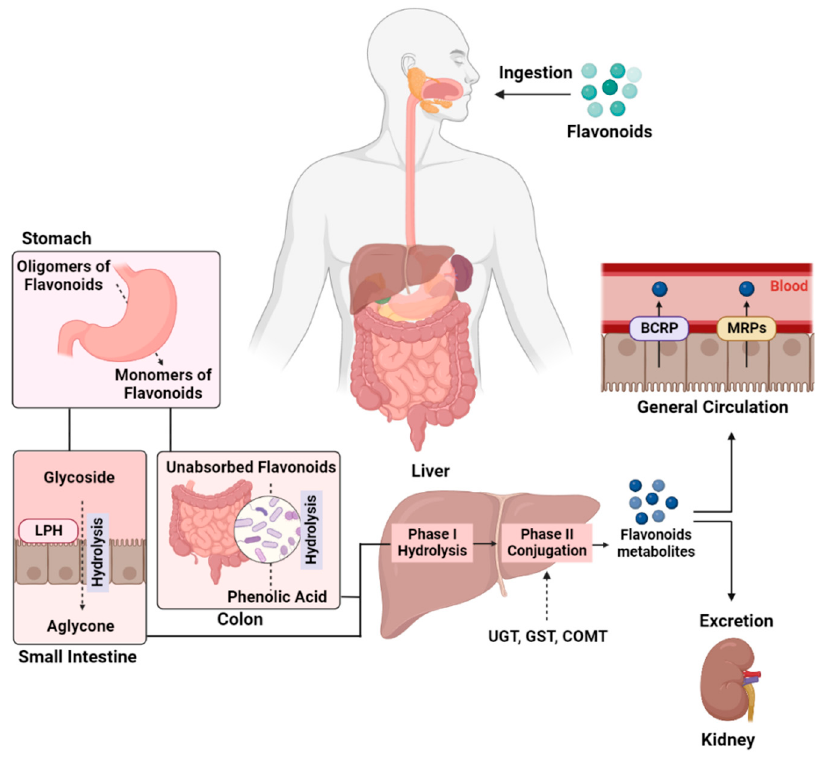
Figure 1. Bioavailability and metabolism of flavonoids. After ingestion, flavonoids hydrolyze into monomers in the acidic environment in the stomach. The flavonoid monomers are further metabolized in the small intestine by LPH, which mediates the hydrolysis of flavonoid glycoside into aglycone. The unabsorbed flavonoids transport to the colon and hydrolyze into phenolic acid by gut microflora. These products transfer to the liver through the hepatic portal vein, where phase I (hydrolysis) and phase II (conjugation by enzymes including UGT, GST, COMT) metabolism produce conjugated metabolites. These metabolites deposit into circulation through transporters present on the canalicular membrane of hepatocytes (BCRP and MRPs) to reach the targeted tissues or to be excreted via kidneys in urine.